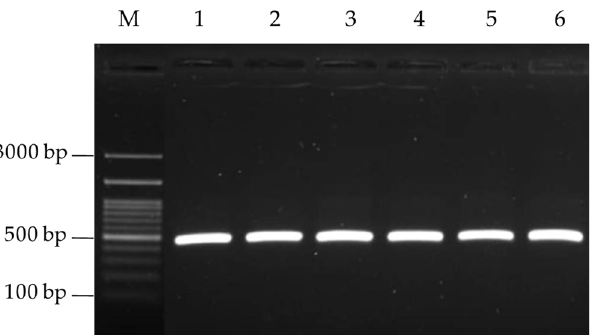
Figure 4. Agarose gel electrophoresis of PCR amplified ITS2 DNA barcode markers from O. tenuiflorum —Rama type (1), O. tenuiflorum —Krishna type (2), O. americanum (3), O. basilicum (4), O. gratissimum (5), and O. kilimandscharicum (6). Lane M was loaded with 100 bp DNA.